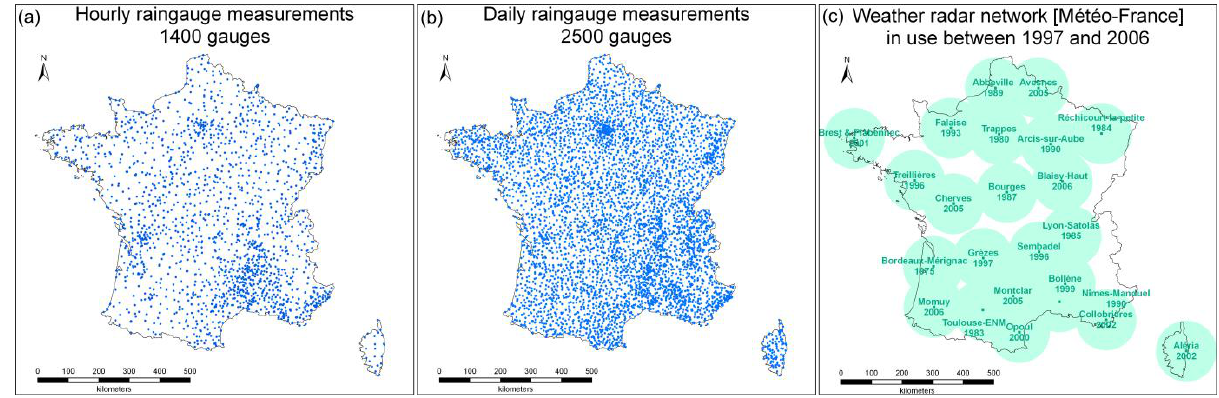
Fig. 1. Structures of the operational measurement network for precipitation estimates between 1997 and 2006. (a) Automatic hourly rain gauge network; (b) daily manual rain gauge network; (c) theoretical coverage of the weather radar (location name and year of installation are indicated).